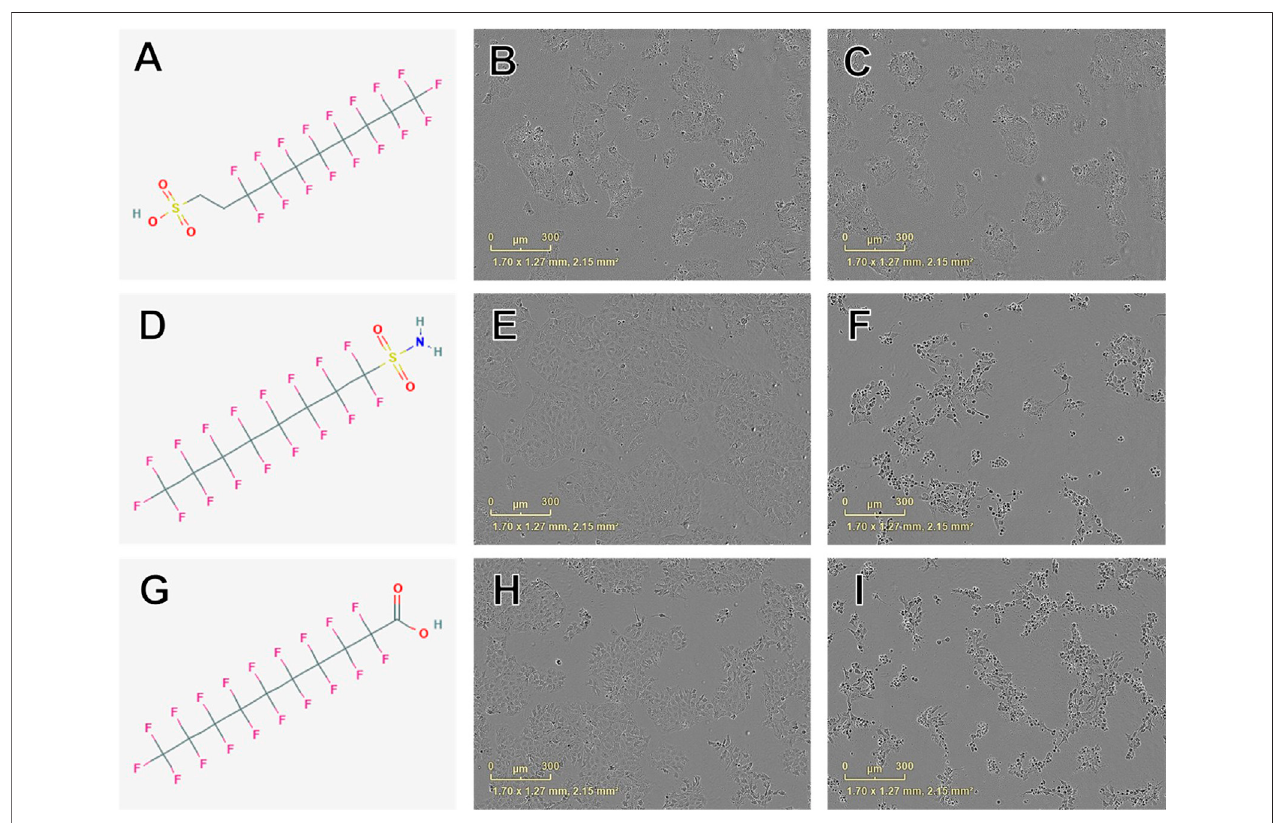
FIGURE 2| Examplesof chemical structures and corresponding phase contrast live cell images obtained from JEG-3 cells after 24 h exposure toPFAS with most pronounced effects on cellular viability. (A) Structure of 8:2 fl uorotelomer sulfonic acid (39108-34-4; viability EC50 ± SE: 160 ± 46 µM); (B) Image of cells exposed to 300 µM39108-34-4; (C) Imageofcellsexposedto500 µM39108-34-4; (D) Structure ofper fl uorooctanesulfonamide(754-91-6;EC50±SE:176±5 µM); (E) Imageof cellsexposedto150 µM754-91-6; (F) Imageofcellsexposedto300 µM754-91-6; (G) Structure ofper fl uorodecanoicacid(335-76-2;EC50±SE:181±26 µM); (H) Image of cells exposed to 250 µM 335-76-2; (I) Image of cells exposed to 350 µM 335-76-2. Mild to moderate cell stress is apparent in (B) , (E) , and (H) marked by darkened, condensed nuclei and increased fi broblastic projections. Moderate to severe cell stress and death is apparent in (C) , (F) , and (I)